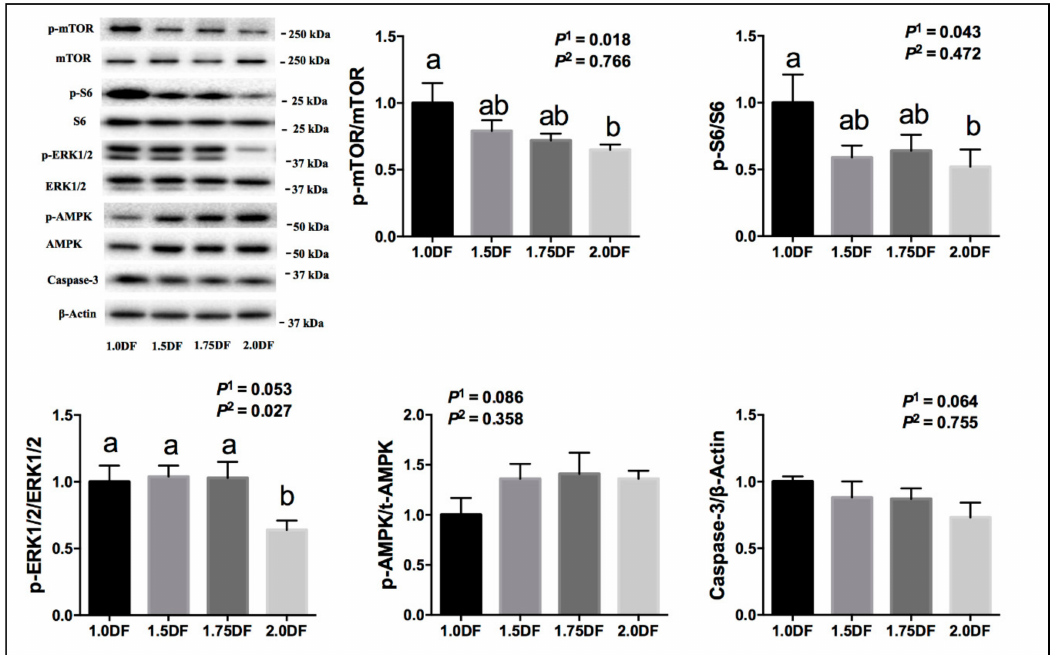
Figure 3. E ff ects of dietary fiber intake levels on the gene expression of ovarian tissues in gilts on the 19th day of the 3rd estrous cycle. Data are expressed as means ± SE; n = 6; DF, dietary fiber; P 1 denotes linear e ff ects; P 2 denotes quadratic e ff ects; a,b denotes p <